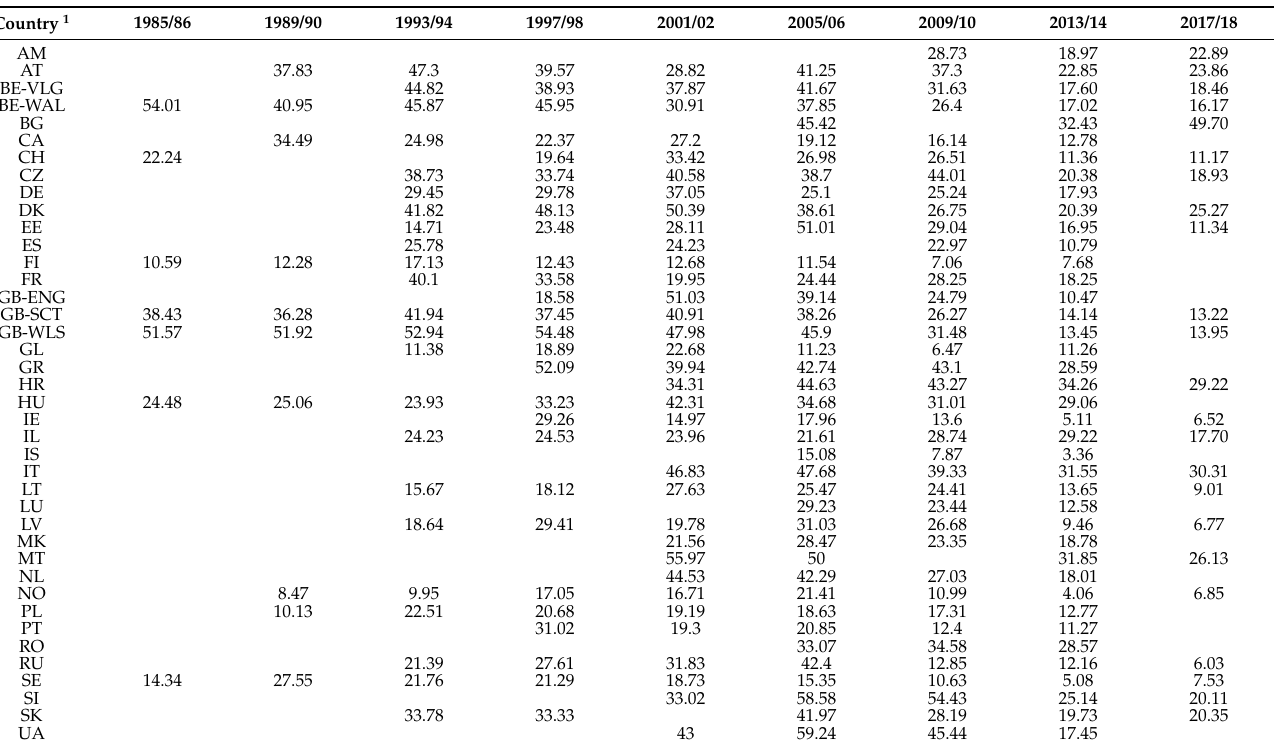
Table 1. Prevalence (%) of weekly/daily alcohol consumption by country and wave from 1985/86 to 2017/18 among